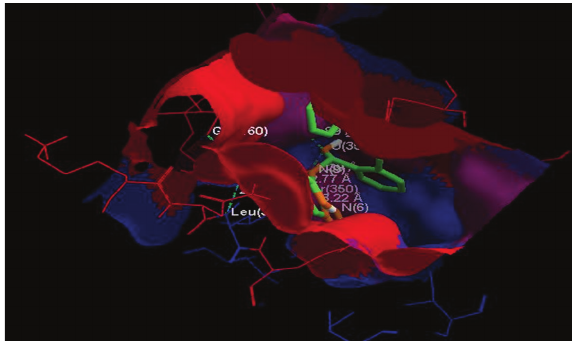
Figure4:Themodelshowinghydrophobicinteractionsofpredicted compound 2 (Table 2) with the enzyme H + /K + -ATPase. The red surface shows strong hydrophobic zone and blue one the low hydrophobic zone.